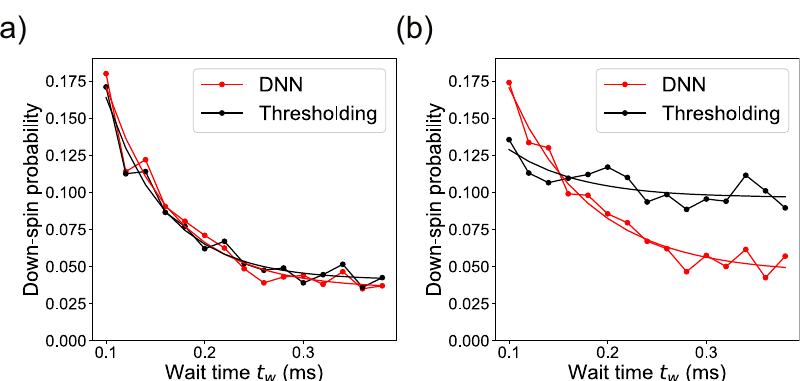
Fig. 4 Spin relaxation measurements using the DNN classi fi er. Spin relaxation measurement results using the DNN classi fi cation and thresholding in Dot4. In the DNN classi fi cation, we trained the network following the procedure as shown in Fig. 3a in Dot4. a Down-spin probability versus wait time t w , out of a total 2000 traces taken for each waiting time for both the DNN classi fi cation and thresholding. The solid lines are the fi t to an exponential decay curve (see details in the main text). The threshold value is optimized to maximize the visibility of decrease in the count of down-spin. b The down-spin probability versus wait time t w in the presence of arti fi cially added Gaussian noise.